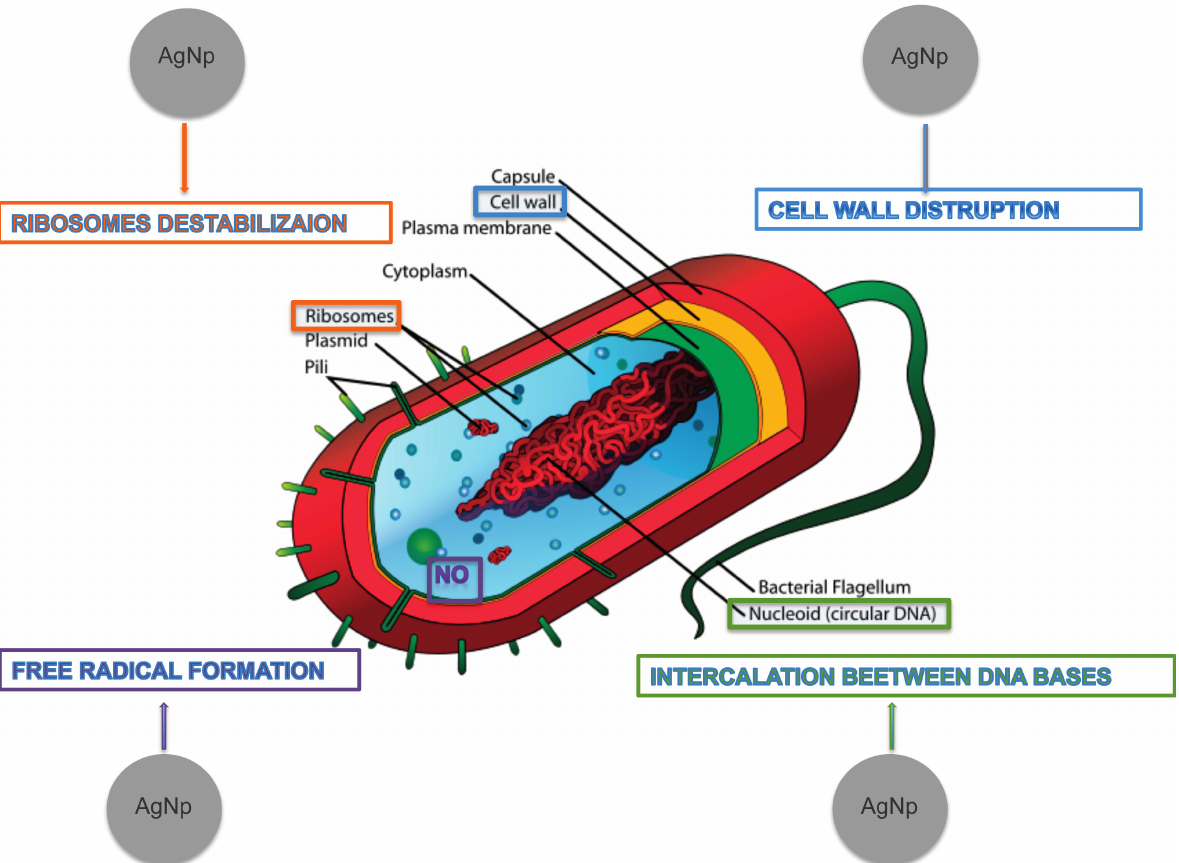
Figure 1. Mechanisms of AgNPs’ toxic